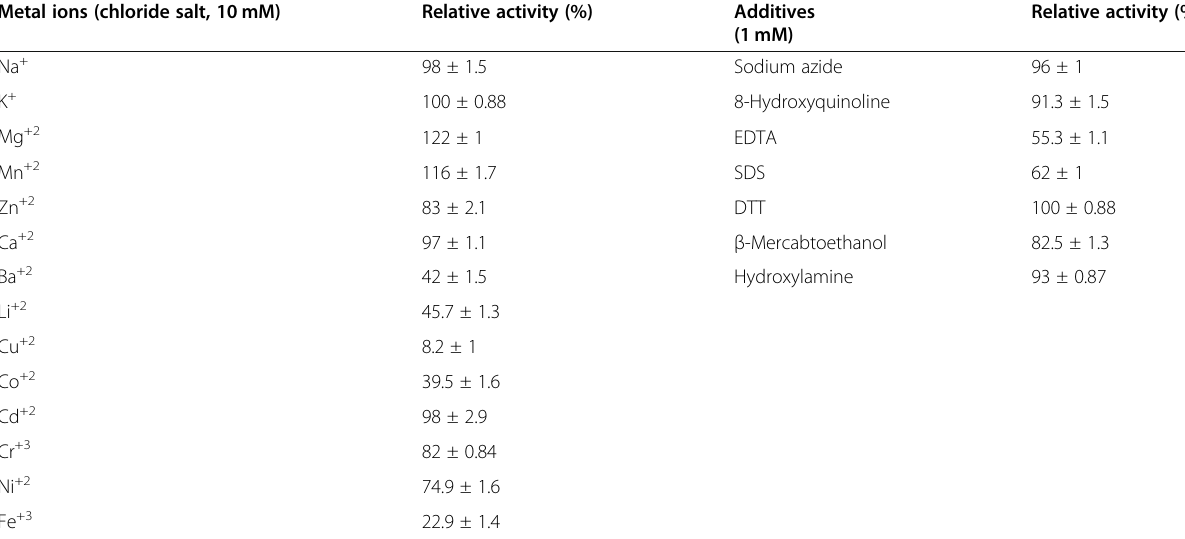
Table 4 Effect of metal ions and additives on β -galactosidase activity Metal ions (chloride salt, 10